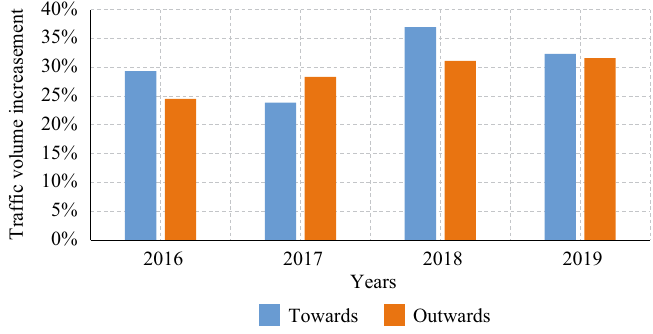
Figure 2. Traffic volume increase towards and outward Palanga during